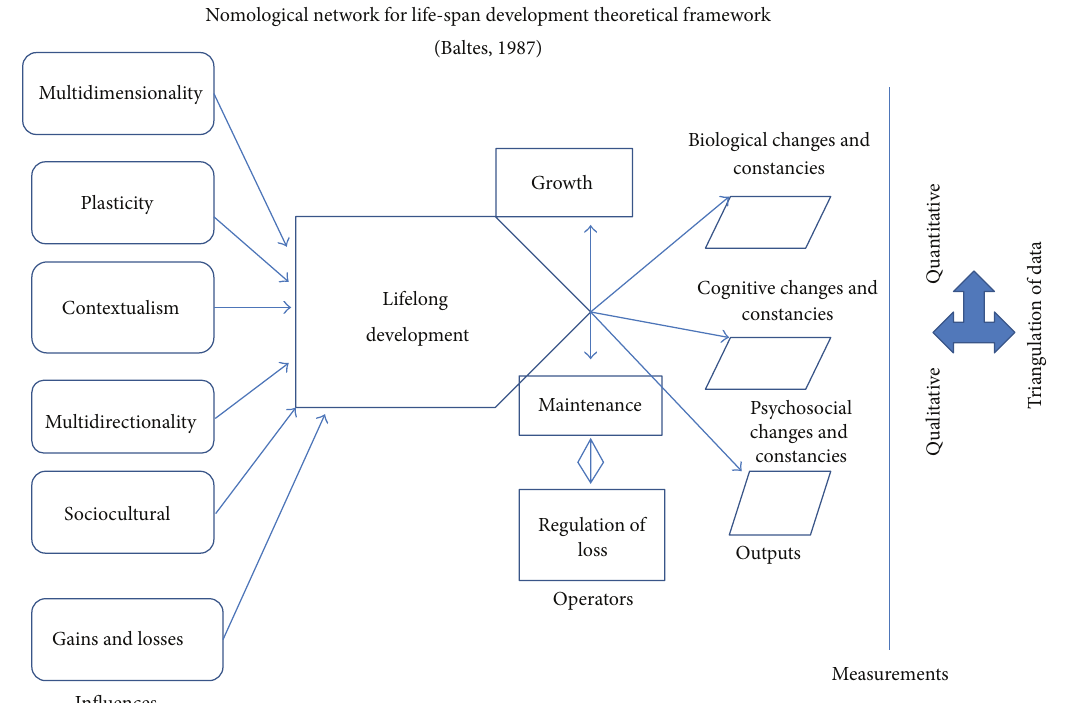
Figure 1: Nomological network for life-span development theoretical framework